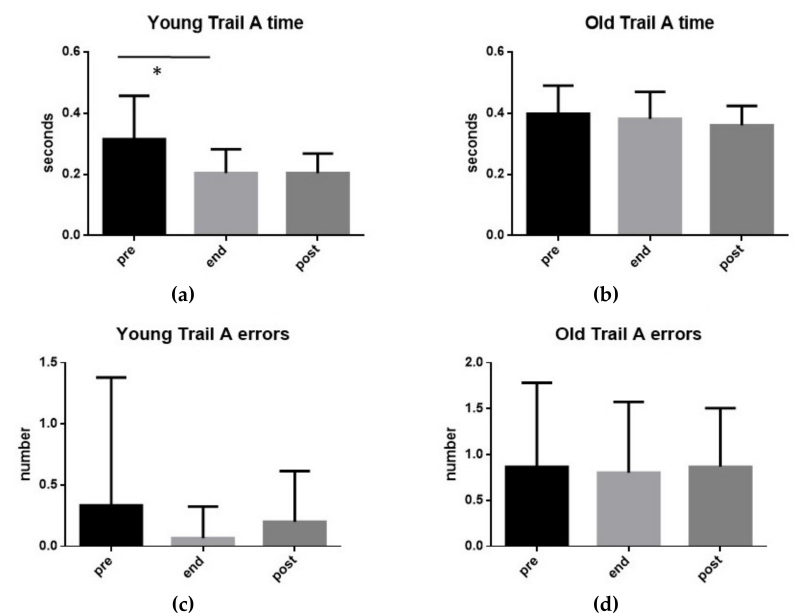
Figure 4. TMT-A. Execution time ( a , b ) and number of errors ( c , d ) found in the 15 subjects of group YOUNG ( a , c ) and in the 15 subjects of group OLD ( b , d ) performing an exhaustive exercise. Mean values measured before the exercise (pre), at its conclusion (end), as well as 15 min after its end (post) are shown. Symbols from ANOVA with Dunn’s multiple comparison test: * p < 0.05.